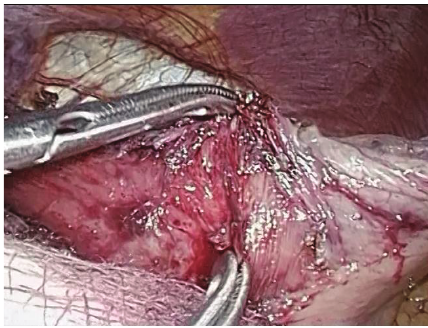
Figure 1: Blunt dissection for myotomy. Figure 2: Myotomy extent proximal and distal to the LES.